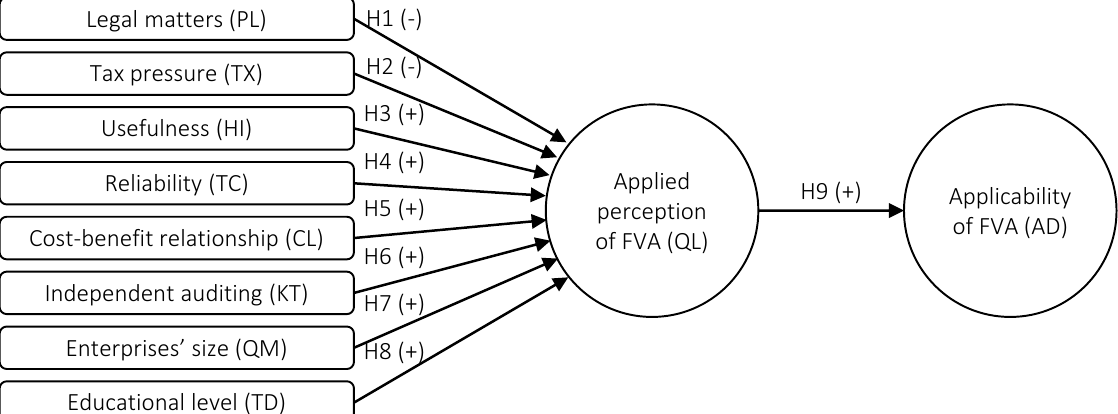
Figure 1. Conceptual